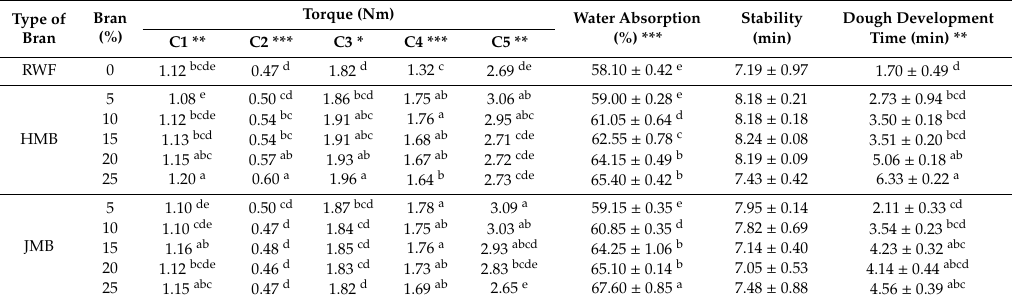
Torque (Nm) Water Absorption